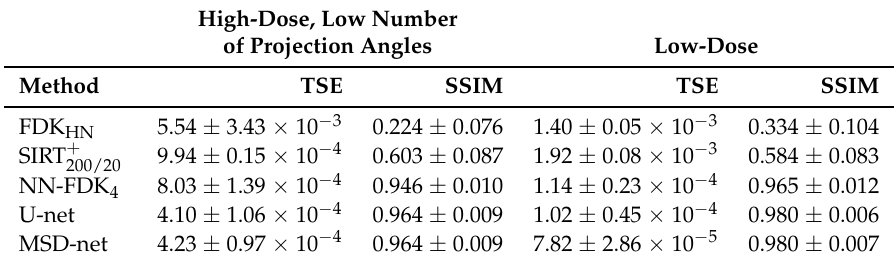
Table 4. Average and standard deviation of the quantitative measures computed over 6 walnut datasets. The high-dose low projection angle reconstruction problem has N a = 32 projection angles, the low-dose reconstruction problem has N a = 500 projection angles. For the high-dose data, we used 200 iterations of SIRT, and for the low-dose data, we used 20 iterations of SIRT. The NN-FDK reconstruction time is 4-10 times lower than U-net, MSD-net and SIRT + , and approximately 40 times lower than SIRT + . 20 200